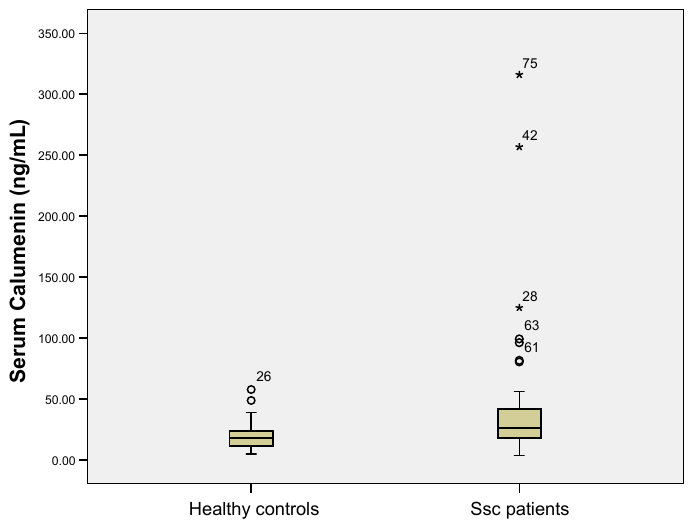
Figure 1. Serum calumenin levels were higher in Ssc (systemic sclerosis) patients compared to healthy controls ( p = 0.002, Mann Whitney U test). The circles, stars and numbers in figure represent the patient ID in the database that are considered outliers by the statistical software used.